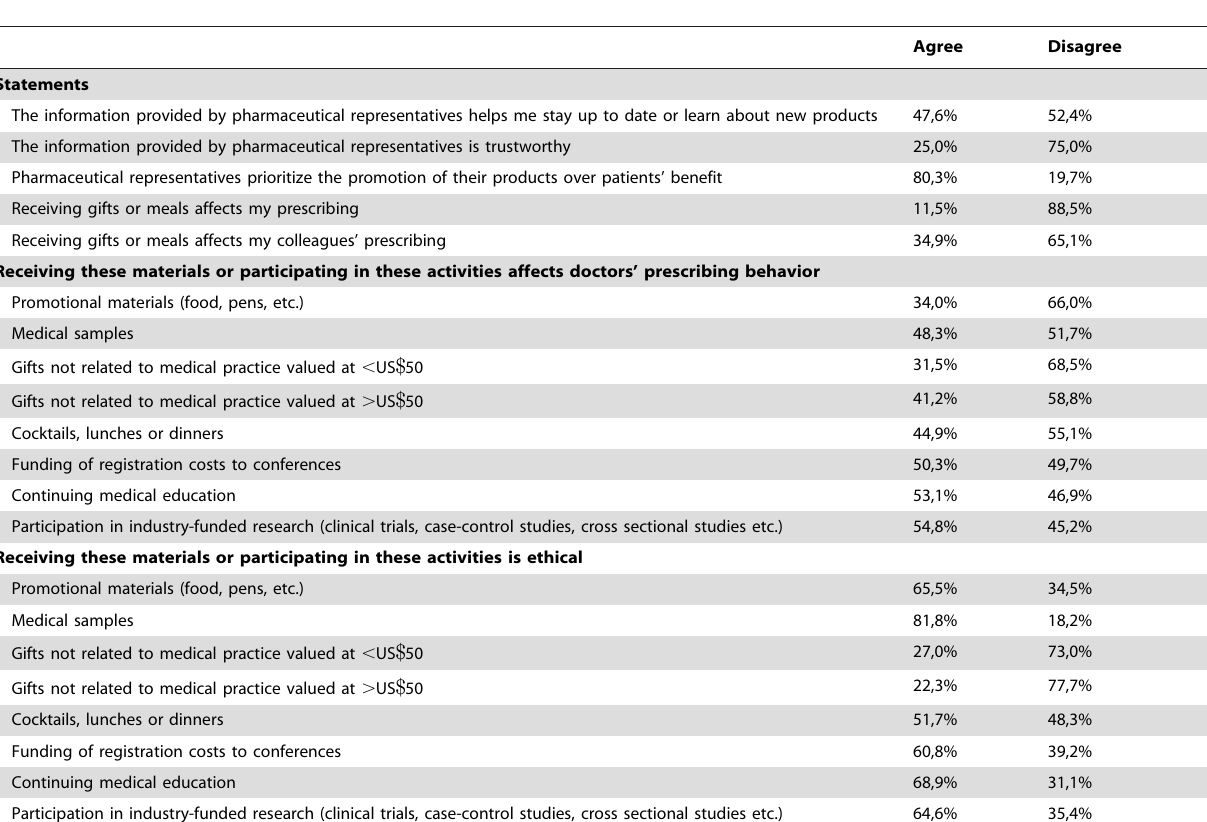
Table 2. Percentage of participants who agree or disagree with the following